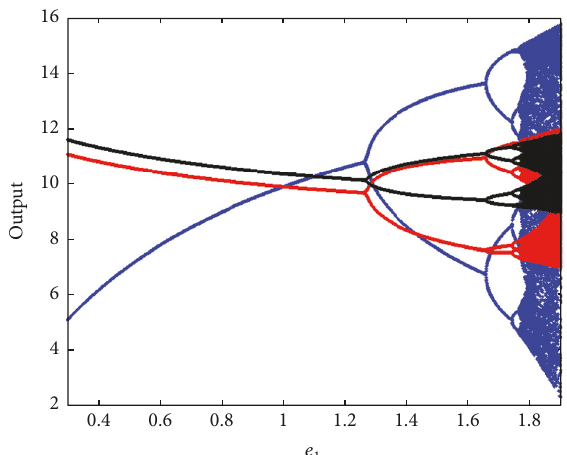
Figure 14: Bifurcation diagram with 𝑒 1 , 𝛼 = 0.2 , 𝛽 = 0.2 , and 𝛾 = 0.1 .